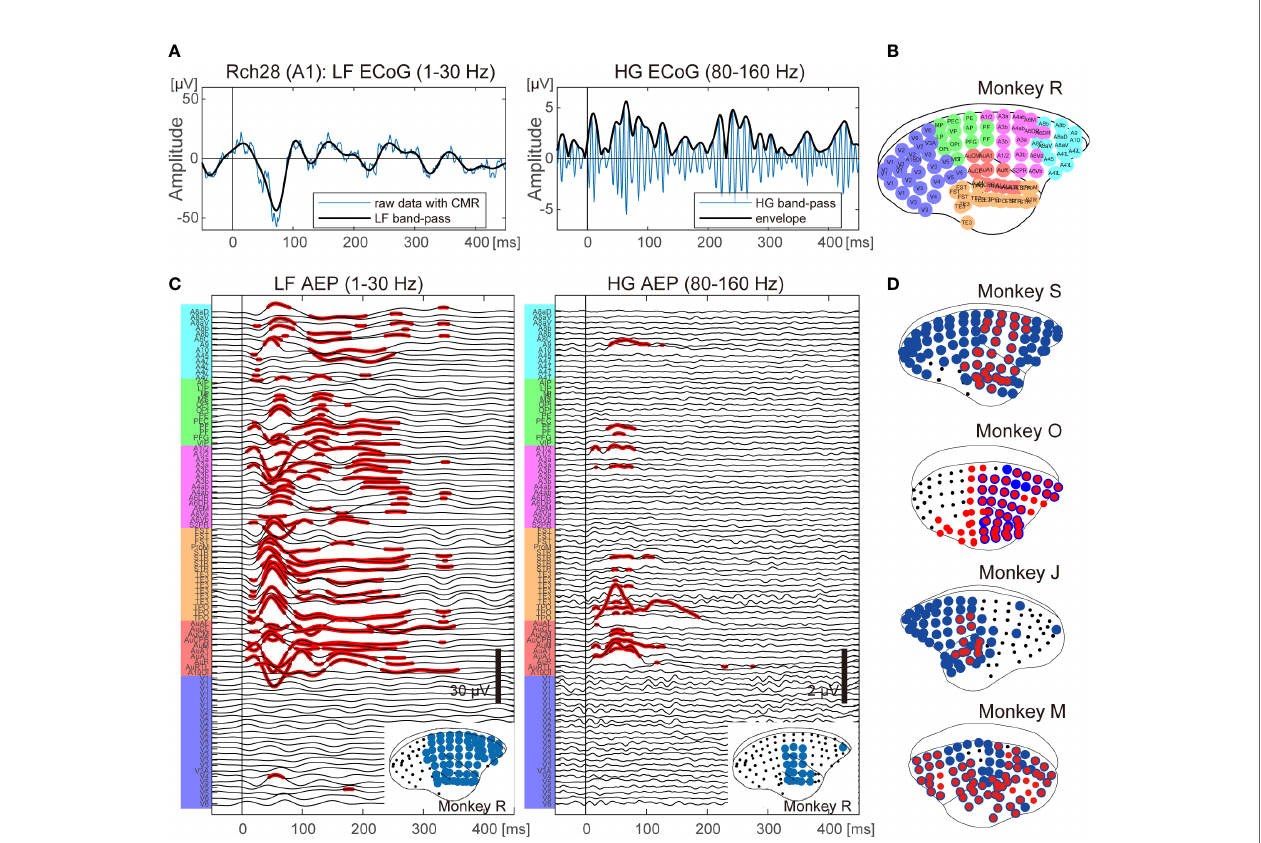
FIGURE 1 | Cortex-wide auditory evoked responses. (A) An example of an ECoG signal of a single trial from the primary auditory area of monkey R. Left: an example of a low frequency (1 – 30 Hz) ECoG (LF). Right: an example of a high frequency (80 – 160 Hz) ECoG (HG). The vertical bars indicate the onset of sound stimuli. (B) The locations of electrodes and putative cortical areas. (C) Auditory evoked potentials of monkey R. LF (left) and HG (right) ECoGs are aligned to sound onset and averaged. The x-axis represents the times and the y-axis represents the labels of the ECoG electrodes in (B) . The red dots indicate the electrodes and times that show signi fi cant responses (adjusted p < 0.00001). The bottom insets show the cortical map for auditory stimuli. The black dots represent the electrode positions. The blue circles represent the electrodes that showed signi fi cant responses. (D) Cortical maps for auditory information processing from the other four monkeys. The black dots represent the electrode positions. The blue and red circles represent the electrodes that showed signi fi cant responses in LF and HG, respectively. Individual AEPs are shown in Supplementary Figure 1